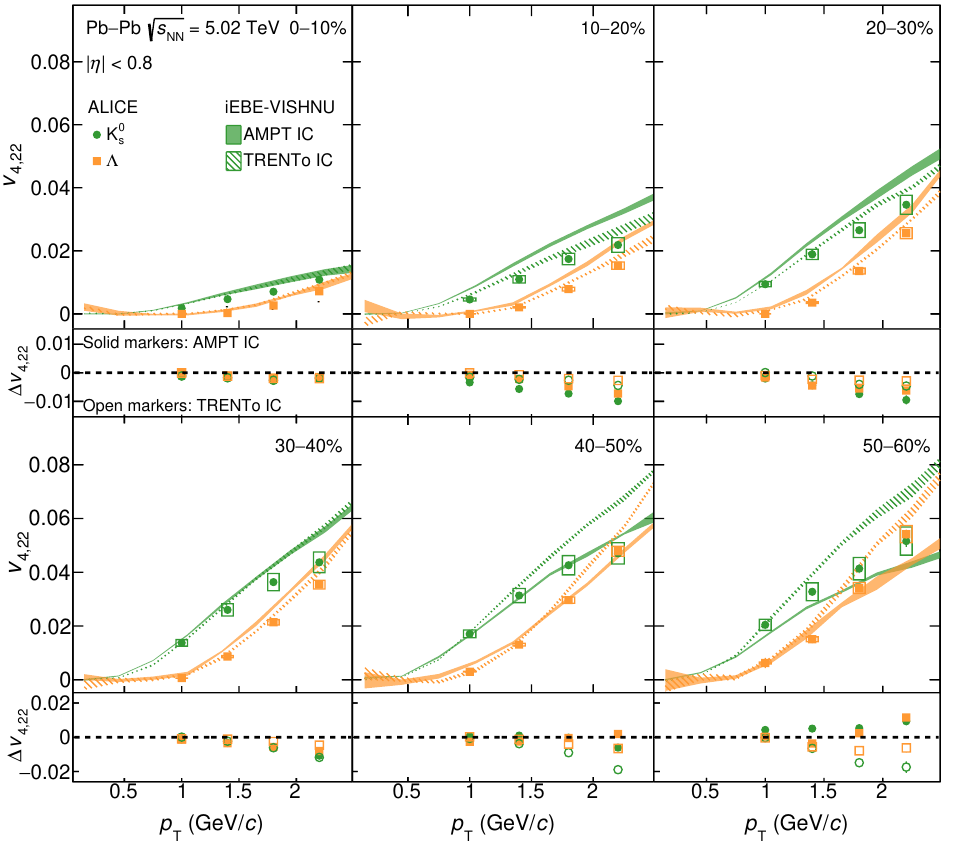
Figure 19 . The p T -di(cid:11)erential v 4 ; 22 of K 0 and (cid:3) + (cid:3) in the 0{10% up to 50{60% centrality S p intervals of Pb-Pb collisions at s NN = 5 : 02 TeVcompared with iEBE-VISHNU hybrid models with two di(cid:11)erent sets of initial parameters: AMPT initial conditions ( (cid:17)=s = 0.08 and (cid:16)=s = 0) shown as solid bands and TRENTo initial conditions ( (cid:17)=s (T) and (cid:16)=s (T)) as hatched bands. The bottom panels show the di(cid:11)erence between the measurements and each model. Statistical and systematic uncertainties are shown as bars and boxes,